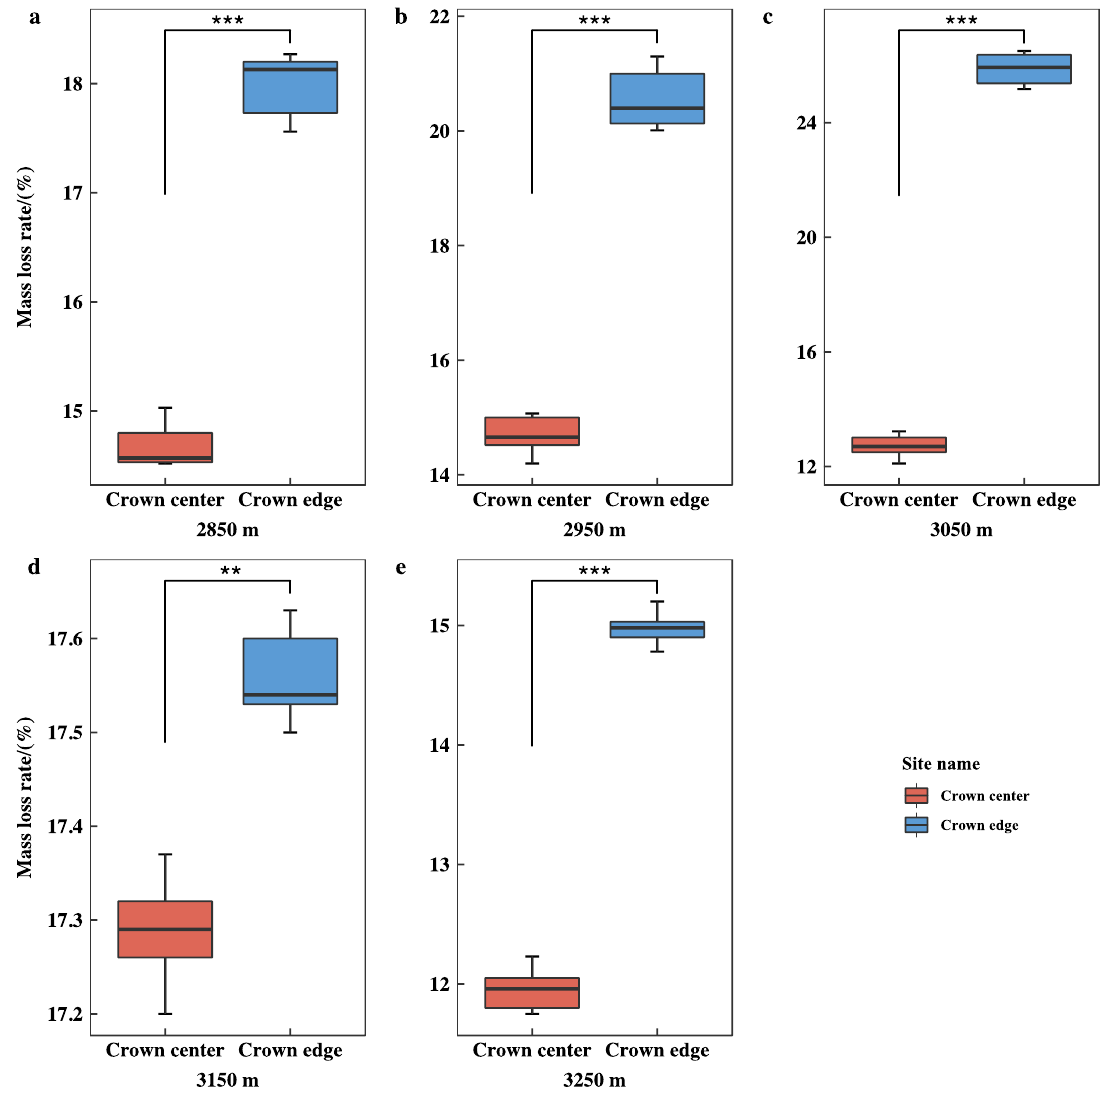
Figure 4. Initial mass loss rate (%) of Qinghai spruce leaf litter from CC and CE at different altitudes in the growing season. ( a ) Represents the initial mass loss rate (%) of Qinghai spruce leaf litter in 2850m CC and CE plots. ( b ) Represents the initial mass loss rate (%) of Qinghai spruce leaf litter in 2950m CC and CE plots. ( c ) Represents the initial mass loss rate (%) of Qinghai spruce leaf litter in 3050m CC and CE plots. ( d ) Represents the initial mass loss rate (%) of Qinghai spruce leaf litter in 3150m CC and CE plots. ( e ) Represents the initial mass loss rate (%) of Qinghai spruce leaf litter in 3250m CC and CE plots. Notes: Values are from bulk litter of CC and CE sites. n = 5. **, p < 0.0l; ***, p < 0.001.